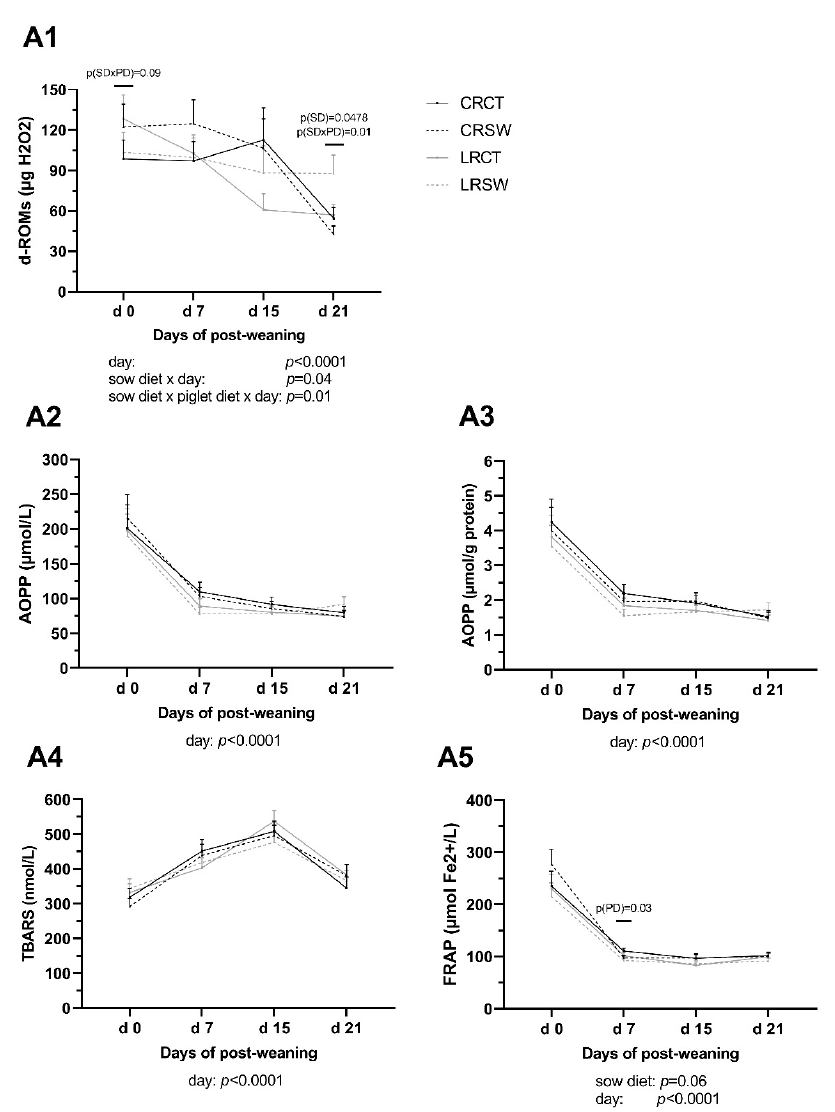
Figure 4. Concentrations of oxidative stress indicators of piglet plasma during the post-weaning period. A1 : The derivatives of reactive oxygen metabolites (d-ROMs); A2 : Advanced oxidation products of proteins (AOPP, µ mol / L); A3 : AOPP ( µ mol / g protein); A4 : Thiobarbituric acid reactive substances (TBARS); A5 : Ferric reducing ability of plasma (FRAP). CRCT: piglets fed no seaweed (SW, Ascophyllum nodosum ), which were nursed by sows fed dietary ω 6: ω 3 ratio = 13:1 during gestation, starting from day 28 (G28) and 10:1 during lactation. CRSW: piglets fed SW, which were nursed by sows fed dietary ω 6: ω 3 ratio = 13:1 during gestation and 10:1 during lactation. LRCT: piglets fed no SW, which were nursed by sows fed dietary ω 6: ω 3 ratio = 4:1 from G28 until the end of lactation. LRSW: piglets fed SW, which were nursed by sows fed dietary ω 6: ω 3 ratio = 4:1 from G28 until the end of lactation. Data are LSM ± SE; n = 10 piglets / group. SD, PD, and SD × PD: e ff ect of sow diet, piglet diet and their interaction between 4 groups at the same sample